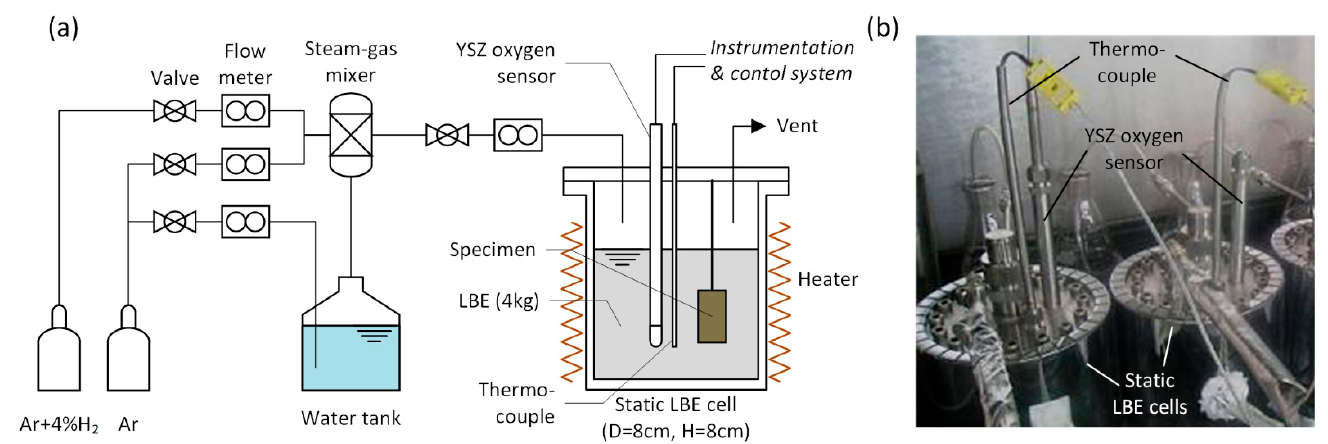
Figure 1. ( a ) Schematic diagram and ( b ) picture of a static lead–bismuth eutectic (LBE) corrosion cell.